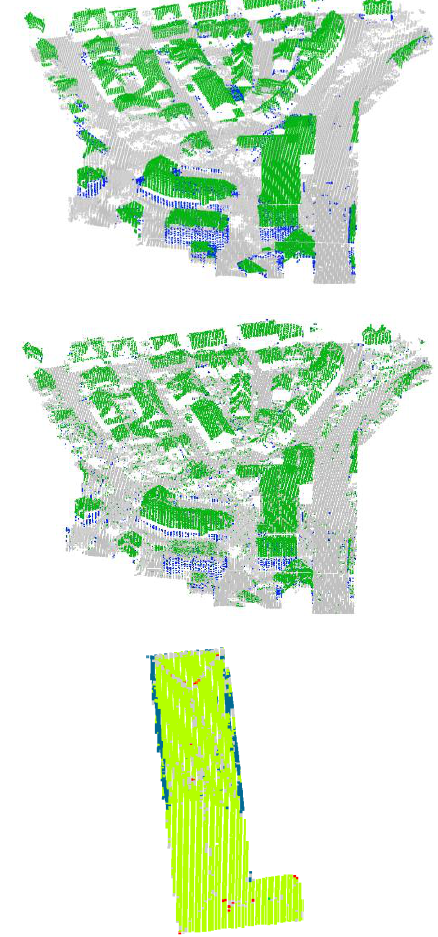
Figure 1. Real and predicted classes left and middle respectively: blue=facades, green=rooftop, grey=others. Right: detail of rooftop with misclassified points in blue and